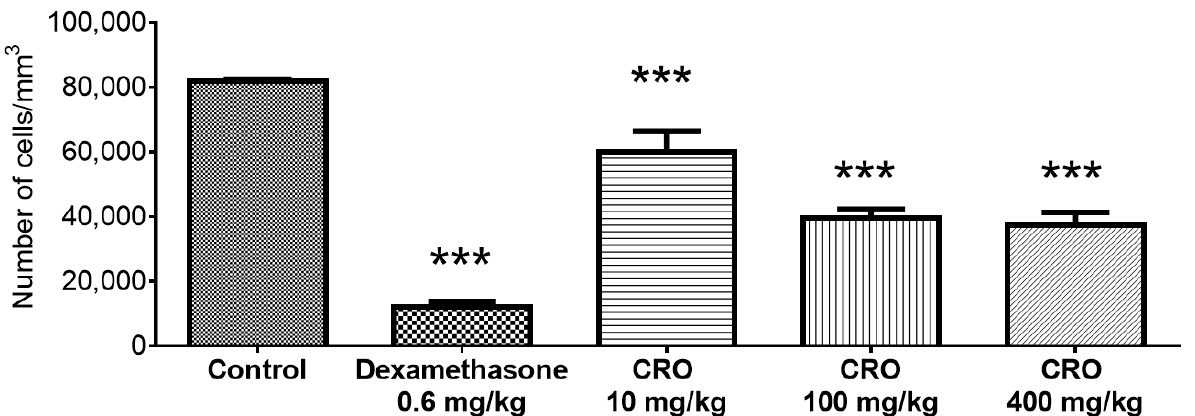
Figure 3. Count of the total number of cells of the exudate in the air pouch. Effect of C. reticulata oleoresin—CRO (10, 100, and 400 mg/kg, orally) and dexamethasone (0.6 mg/kg, orally) on Wistar rats using the air pouch model. Each point represents the mean ± SE of a group of 5 animals. *** p < 0.001 compared to control (vehicle); one-way ANOVA, Newman–Keuls multiple comparison test.